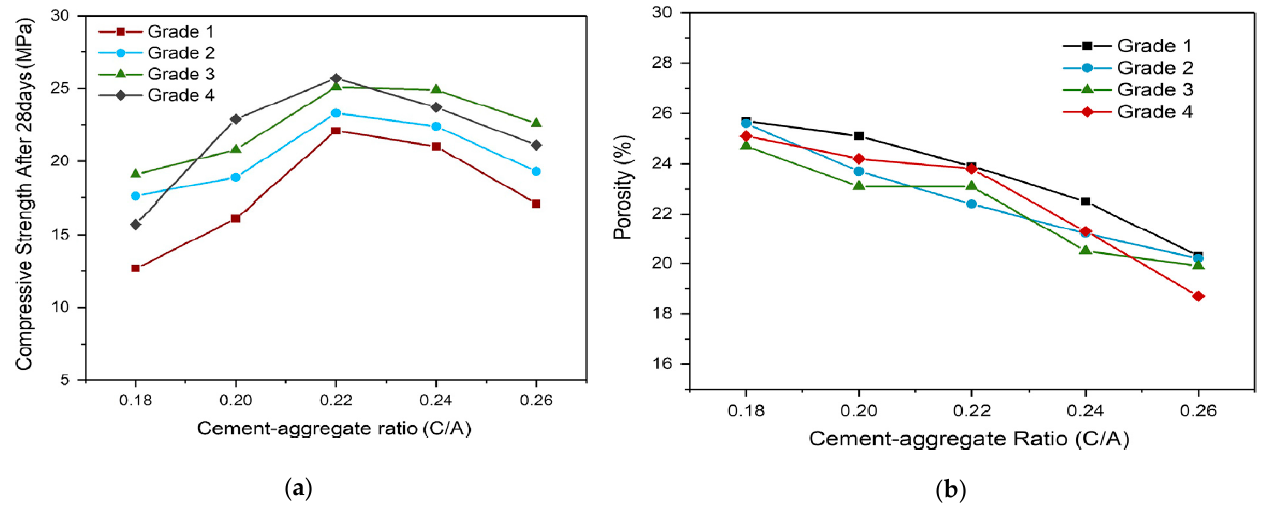
Figure 3. The relationship between: ( a ) compressive strength after 28 days and cement–aggregate ratio by mass (C/A) ratio; ( b ) concrete porosity and C/A ratio